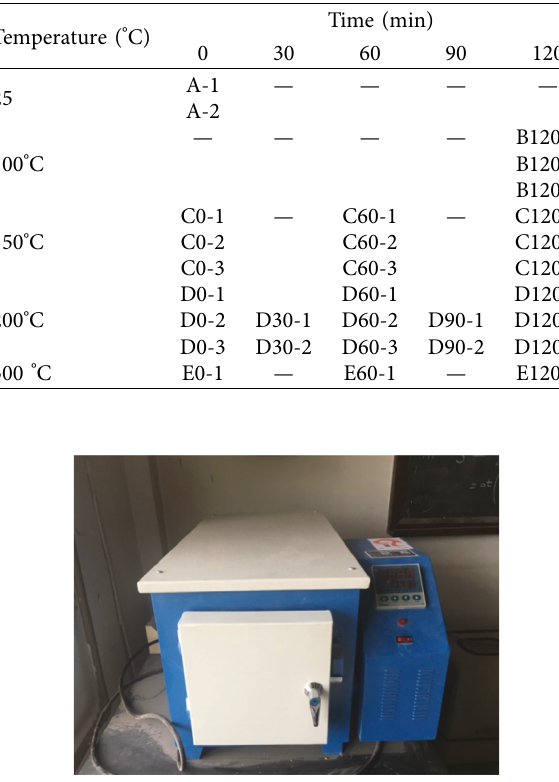
Table 2: Specimen design parameters.